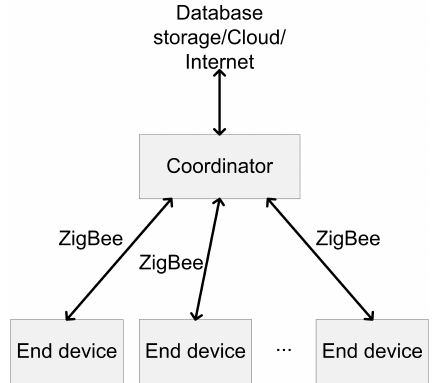
Figure 1. Overview of the considered